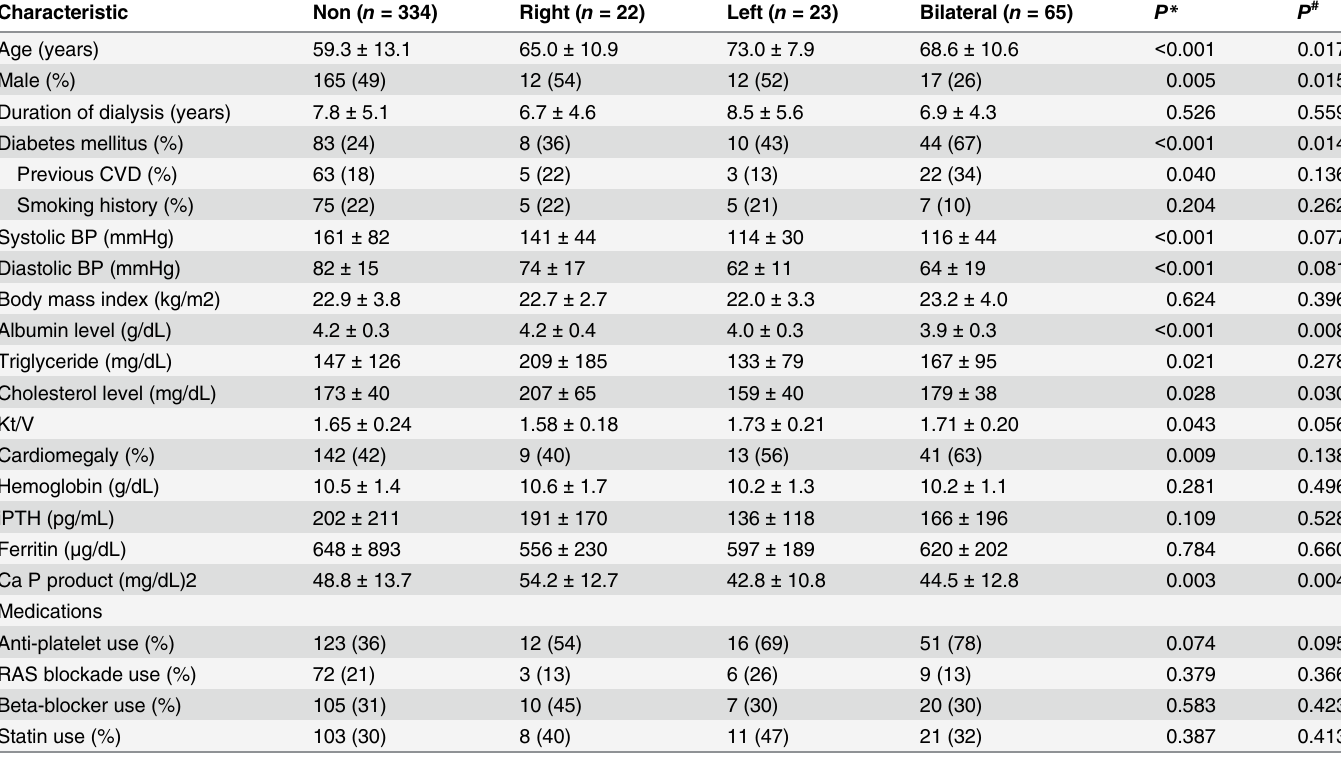
Table 2. Characteristics of patients at inclusion according to the location of